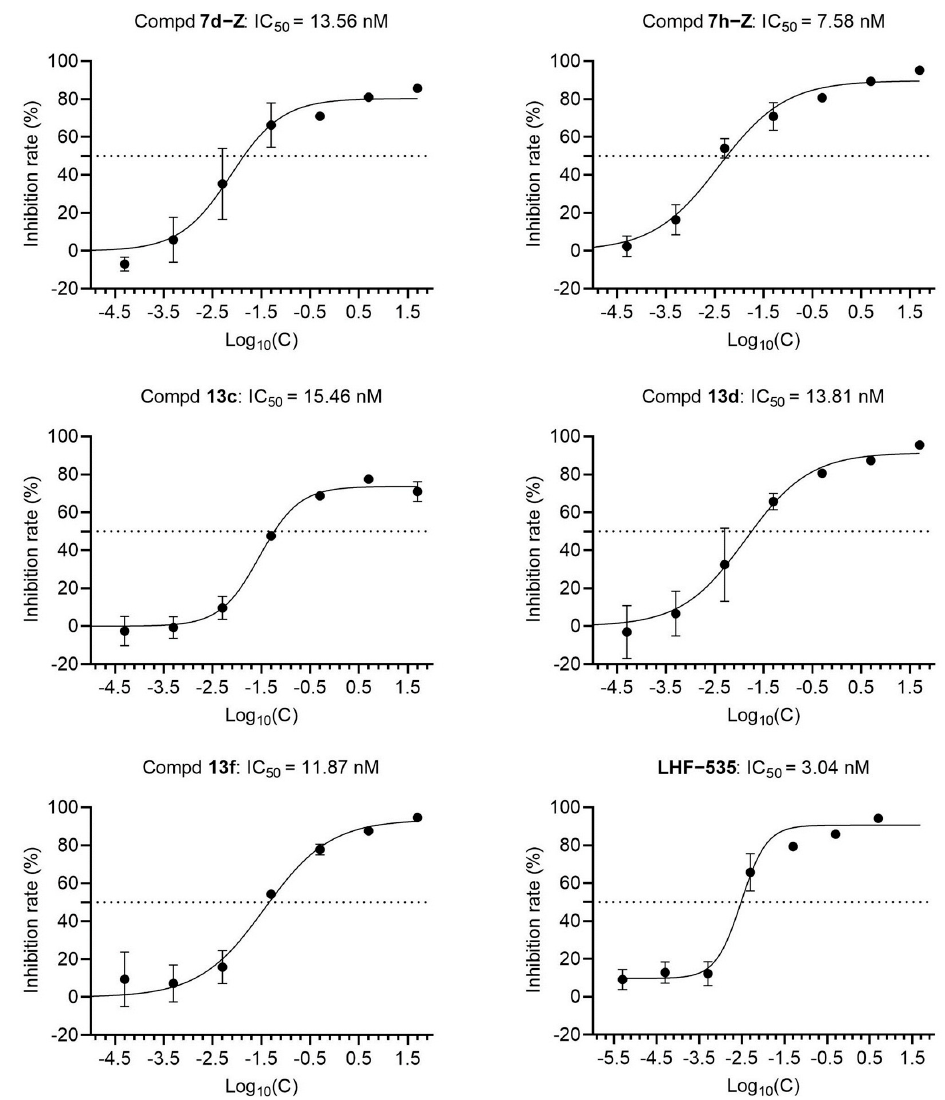
Figure 3. Concentration–response curves of representative compounds 7d − Z , 7h − Z , 13c , 13d , 13f, and LHF − 535 to LASVpv. Table 1. Inhibition of LASVpv pseudotyped viruses by synthetic compounds 7a − 7h(Z/E) .